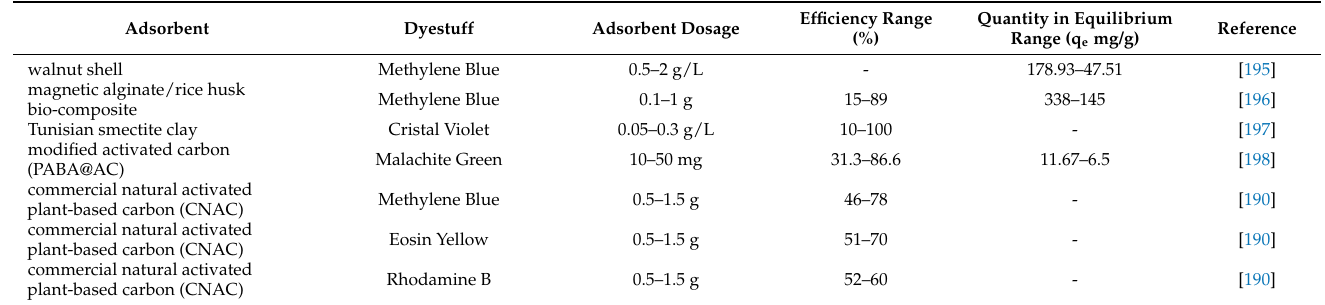
Table 3. Results of various research regarding the effect of initial adsorbent